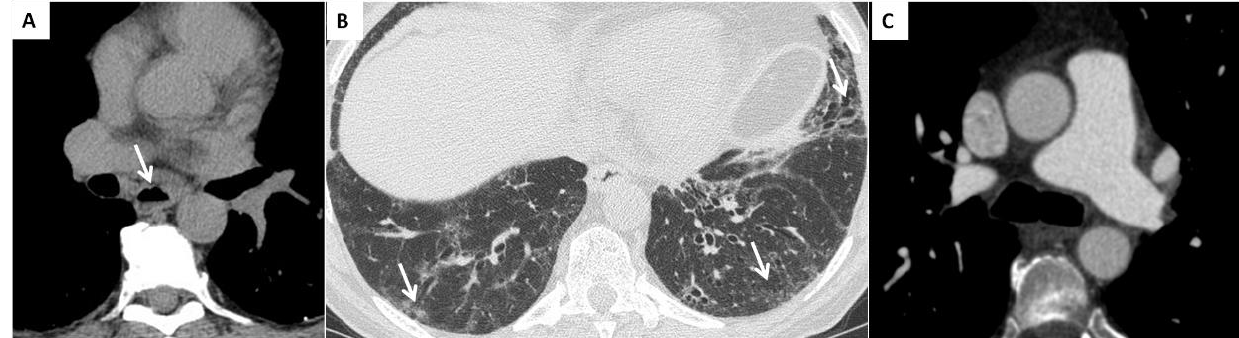
Figure 3. ( A ) Esophageal involvement in a 56-year-old male with a diagnosis of SSc. Axial image with a mediastinal window setting shows a dilatation of the esophagus (diameter >1.2 cm) with an air-fluid level (white arrows); ( B ) Parenchymal signs: axial high resolution CT scan shows a fibrotic NSIP pattern due to the presence of diffuse irregular septal thickening, bronchiectasis and bronchiolectasis on a background of diffuse ground glass opacities (white arrows); ( C ) Vascular signs: a main pulmonary artery with a diameter greater than 36 mm measured in a scanning plane of its bifurcation is a sign of pulmonary hypertension.